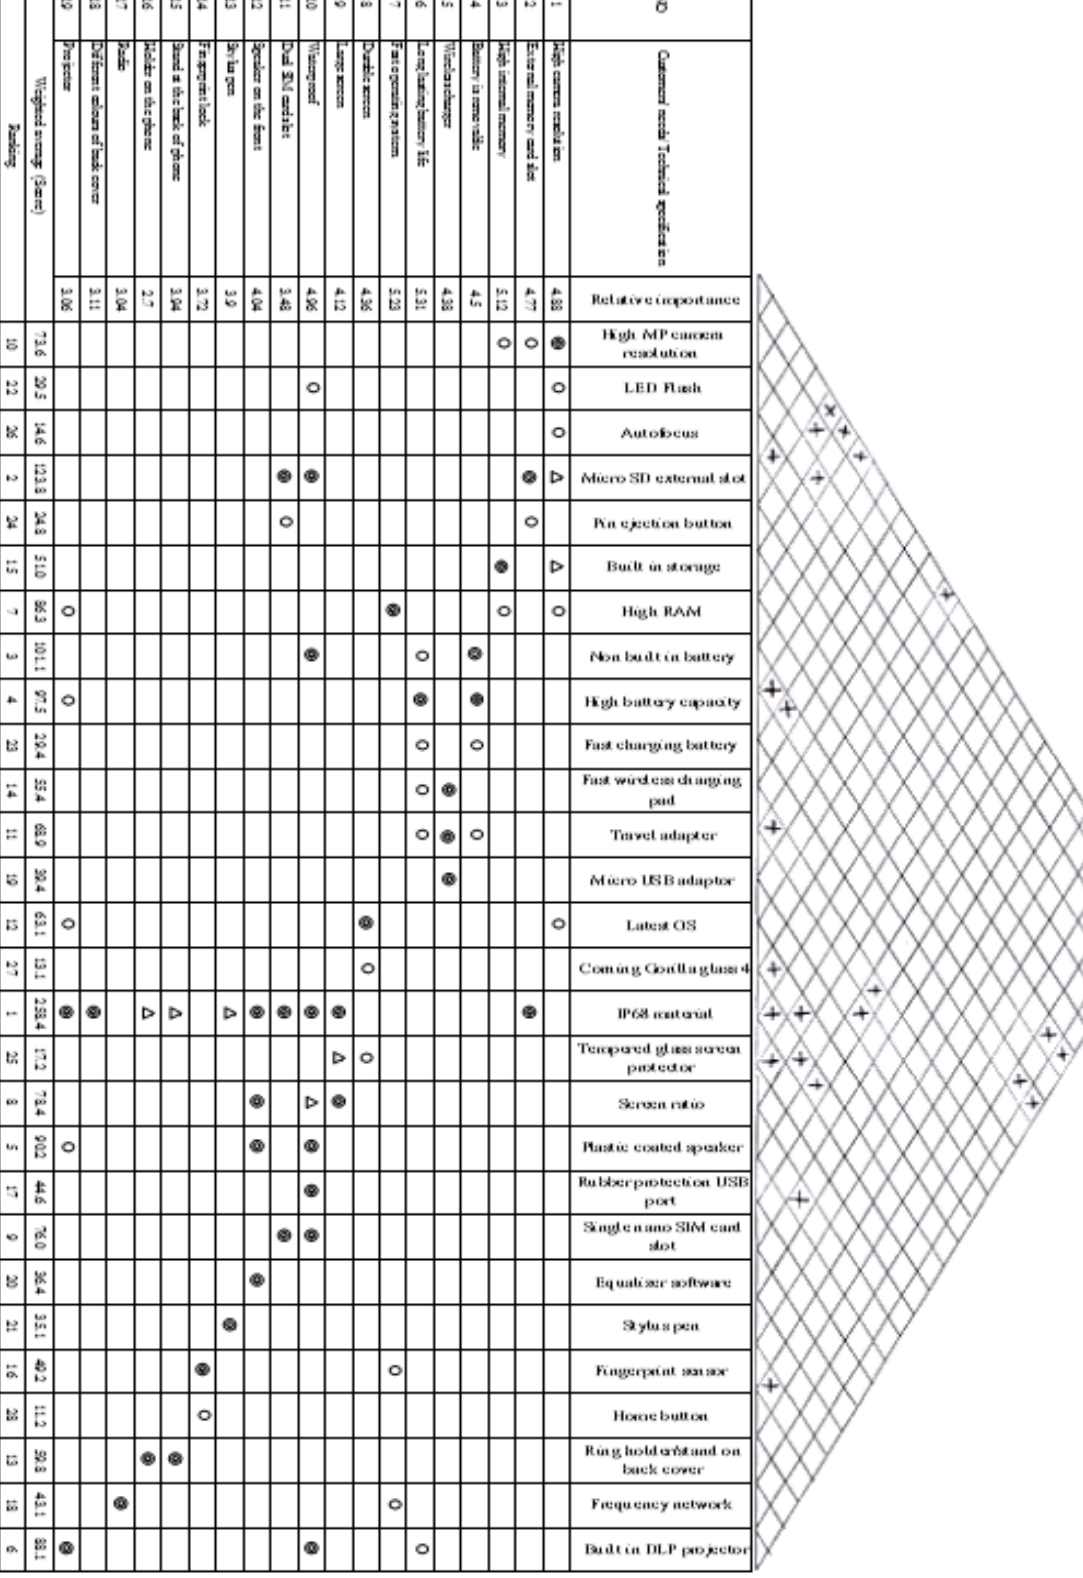
Figure 1: House of